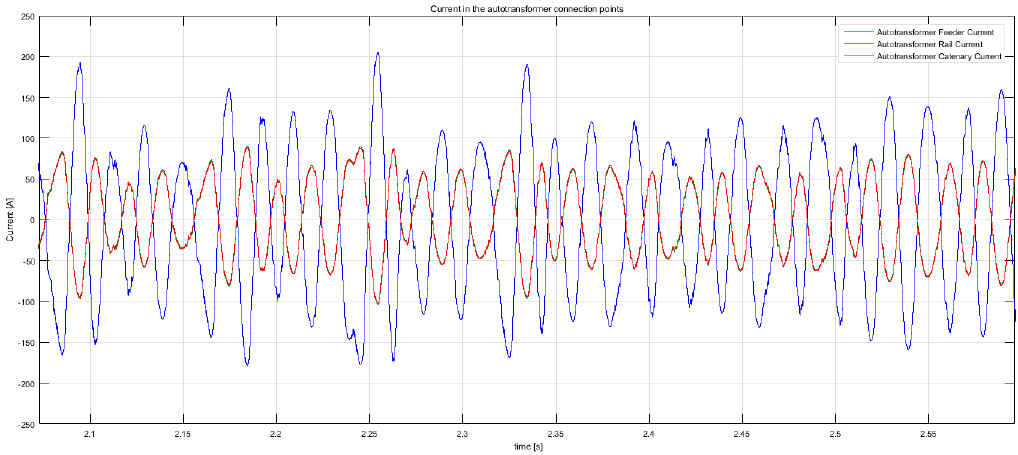
Figure 17. Current drawn by the balancing autotransformer with the charging stations and a train on the tracks.